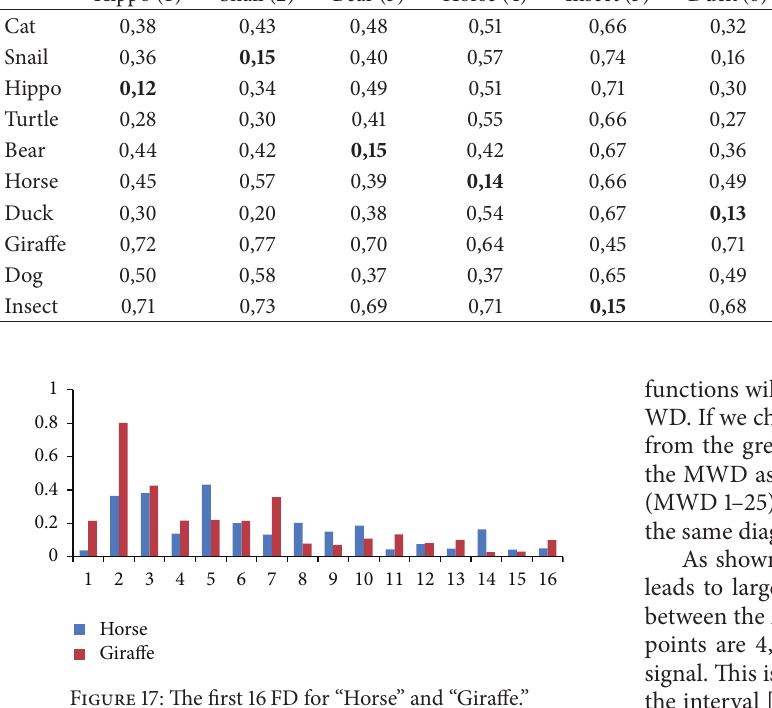
Figure 17: The first 16FD for “Horse” and